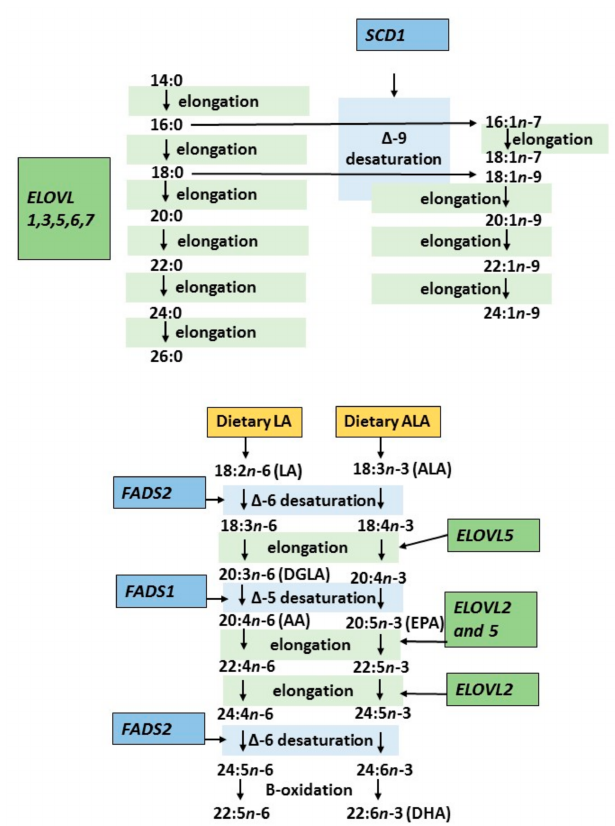
Figure 3. Simplified figure of the synthesis of fatty acids in the human body including key enzymes regulating fatty acid metabolism and genes coding them. AA, arachidonic acid; ALA, alpha-linolenic acid; DGLA, Di-homo-gamma linolenic acid; DHA docosahexaenoic acid; ELOVL, fatty acid elongase; EPA, eicosapentaenoic acid; FADS, fatty acid desaturase; LA, linoleic acid; SCD, stearoyl-CoA desaturase